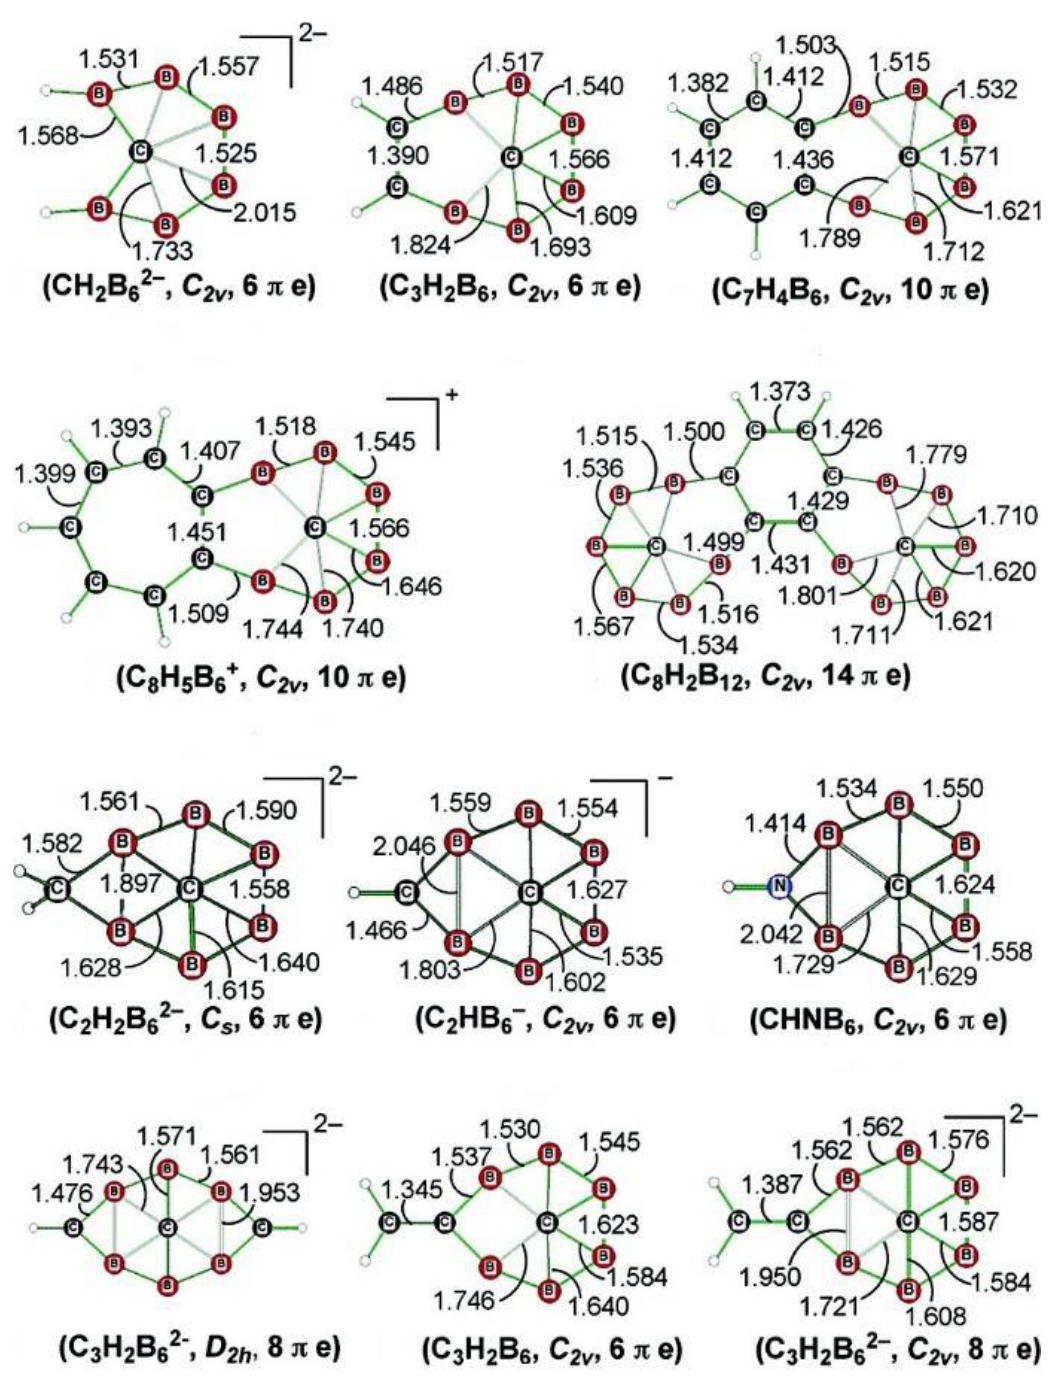
Figure 30. Examples of CB 62− based phC molecules. Bond lengths are shown in Å. Reprinted from ref. [125] with permission from American Chemical Society. Copyright © 2022 American Chemical Society.